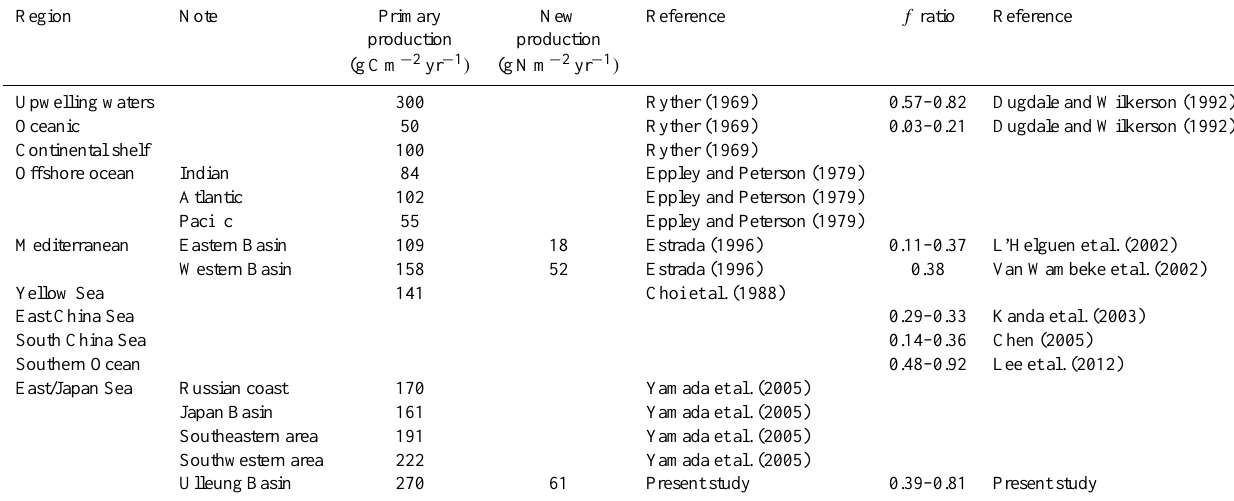
Table 1. Previous results of primary production, new production, and f ratio in the other regions.